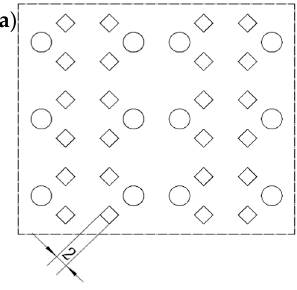
Figure 7. Hole layout scheme of other pre-punched holes. ( a ) Circular-diamond holes, ( b ) Circular- triangle holes, ( c ) Circular-semicircular holes.